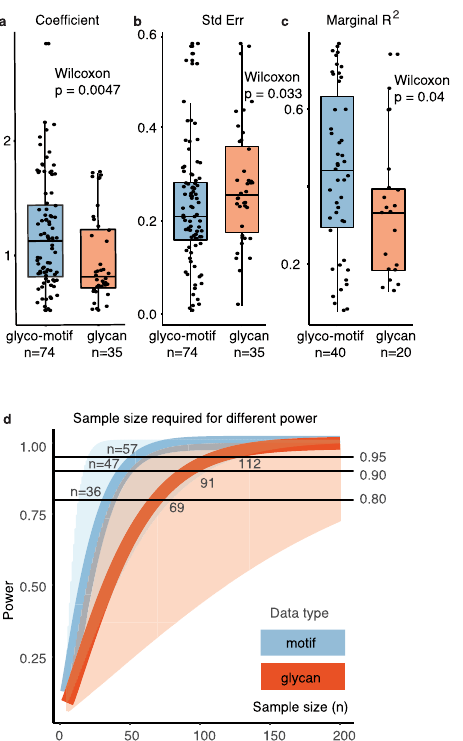
Fig. 6 Glyco-motif level statistics require half as many samples to reach the same level of statistical power as analysis with raw glycans. a , b The use of glyco-motifs improves measures of regression robustness. The coef fi cient magnitude and Standard Error indicate the magnitude of the measured effect and the con fi dence with which a coef fi cient can be estimated. In a , the boxplot illustrates 25th, 50th, and 75th percentiles for regression coef fi cients using glycan data (Min = 0.5094, Q1 = 0.7206, median = 0.8416, Q3 = 1.2706, Max = 1.7166, n = 35) or glyco-motif data